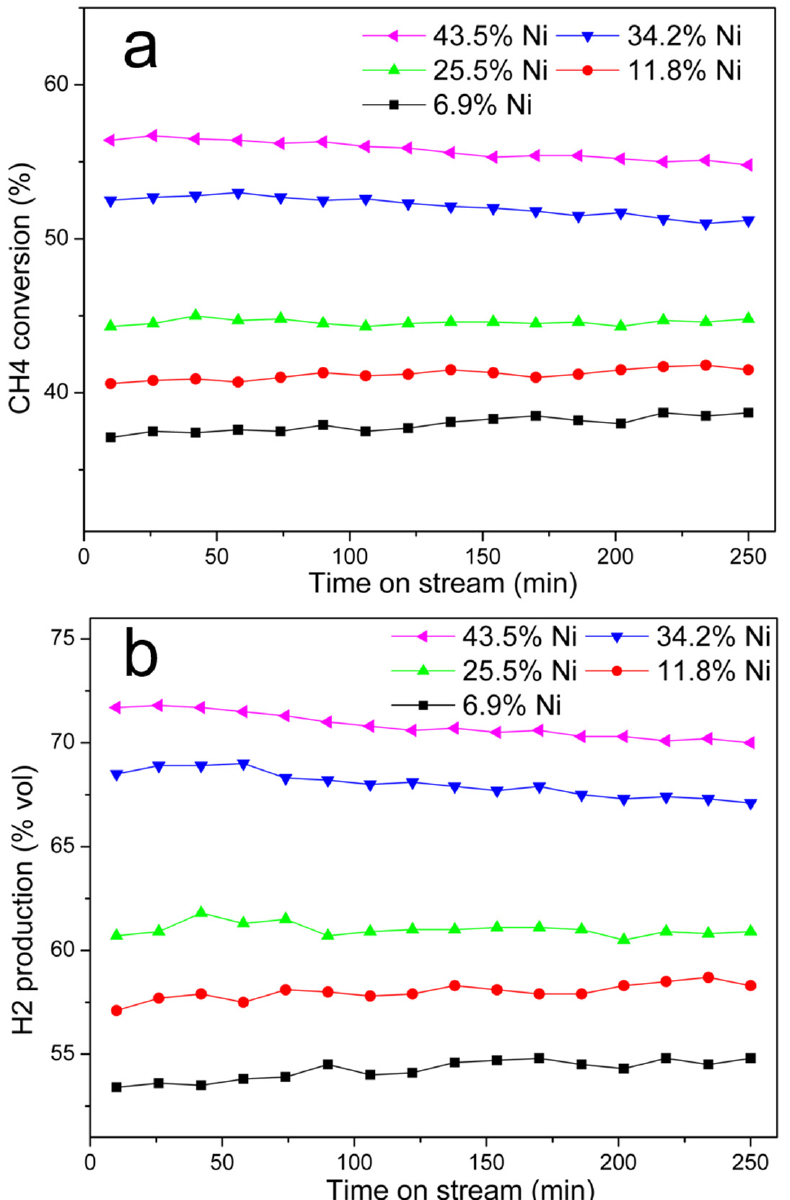
Figure 8. CH 4 conversion and H 2 production over Ni@G samples with different nickel contents (6.9 wt%, 11.8 wt%, 25.5 wt%, 34.2 wt%, and 45.3 wt%). ( a ). CH 4 conversion rate (%) vs. time, ( b ). H 2 vol% in vent gas vs time. Testing temperature: 800 °C; catalyst used: 10 g; gas flow rate: 100 mL/min. Stability of the Catalyst